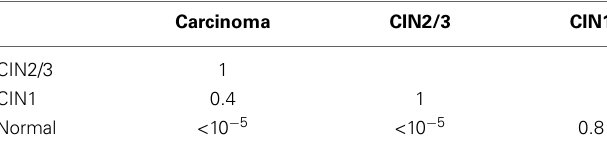
Table 3 | Comparison of HPV fragment counts between cervical histological